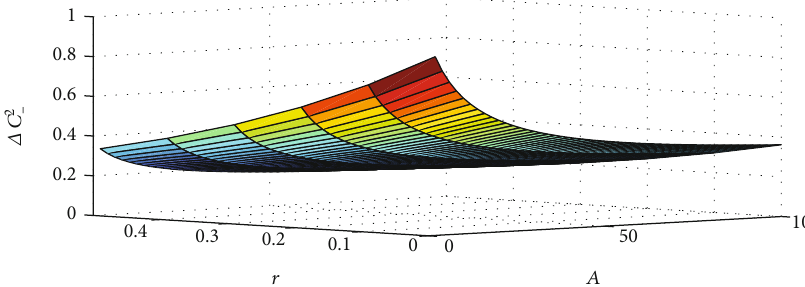
Figure 3: Plots of minus quadrature variances (Equation (25)) versus r and A , for κ = 0 : 8 and η = 0 : 1